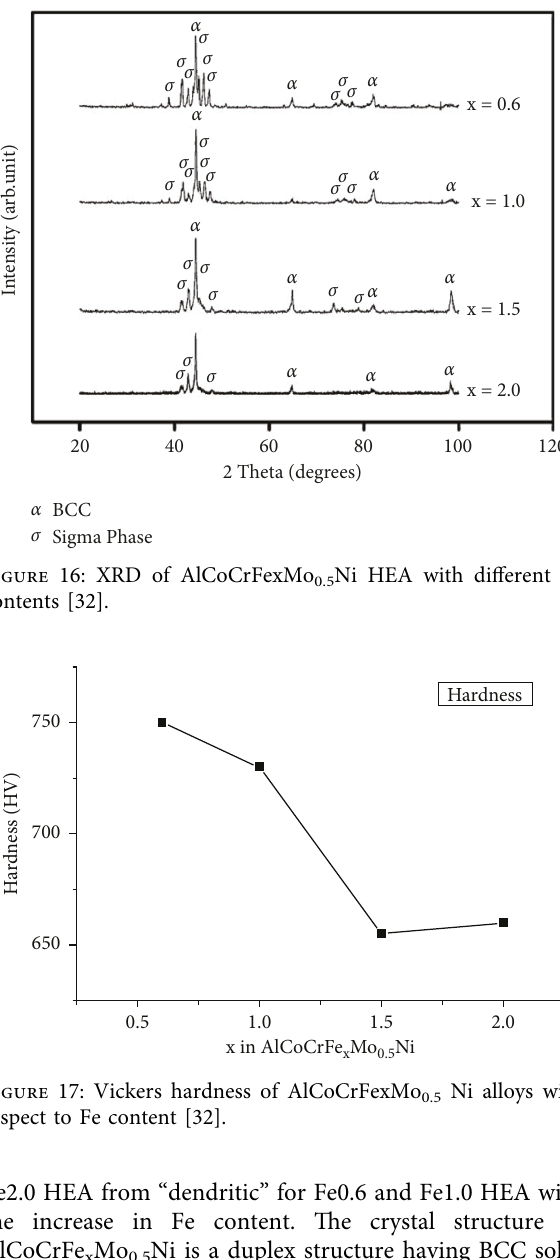
0.5 Ni alloys with